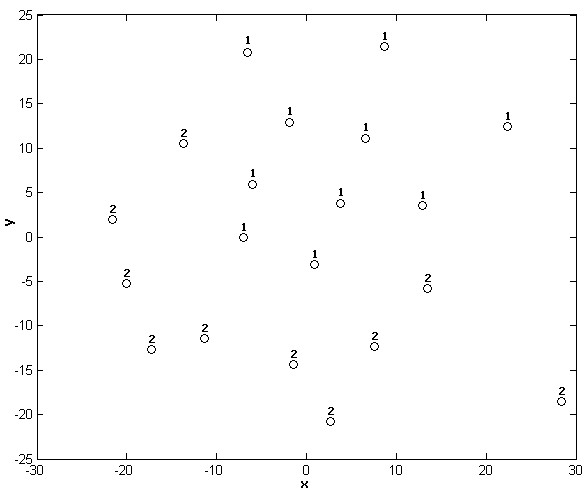
Sammon's mapping of the Parkinson's disease model data. Symbols "1" and "2" represent Parkinson's disease and Normal samples respectively.